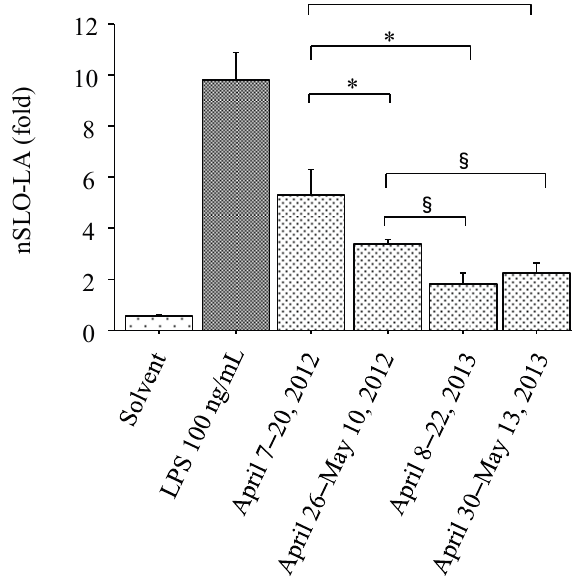
Figure 3. Interleukin-8 transcriptional activity measured using an interleukin -8 luciferase assay in a stable THP-1-derived interleukin-8 reporter cell line. Interleukin-8 transcriptional activity is based on normalized stable luciferase orange luciferase activity (nSLO-LA), which was calculated as stable luciferase orange luciferase activity divided by stable luciferase red luciferase activity. Cells were treated with solvent only (n = 6, negative control), lipopolysaccharide (LPS) (n = 6, 100 ng/mL, positive control), or particulate matter